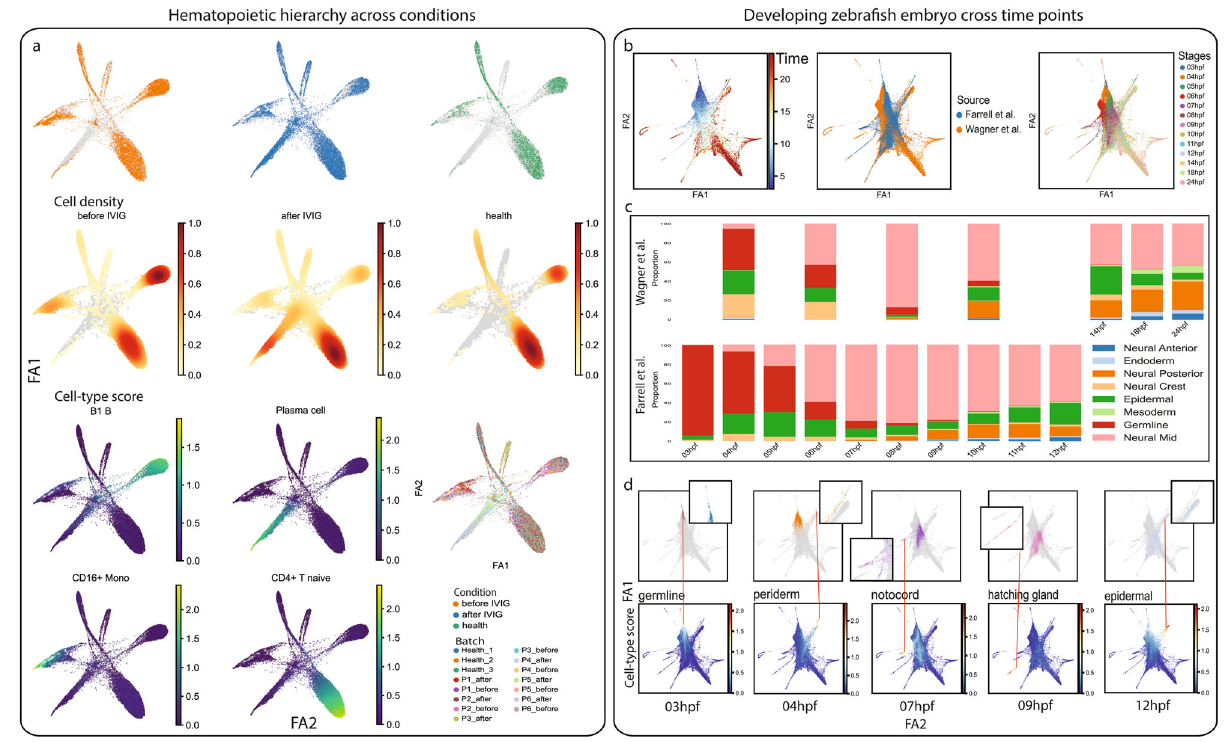
Fig. 1 Integrative lineage analysis using cell-type score matrix. a Integrative lineage analysis for multi-condition human hematopoiesis study 43 . Cell density, cell-type score, and batch id for human hematopoiesis samples under different conditions are visualized separately through the fi rst two ForceAtlas2. b integrative lineage analysis for two developing zebra fi sh embryo data 45,46 . Cells are visualized through UMAP and are colored according to developmental time (left), study id (middle), and developmental stages (right). c Compositions of eight major lineages along the developmental stages in zebra fi sh embryo. All lineages sum up to 1 in one stage, and data from the two studies are visualized separately. d Identi fi cation of lineage origin time. Visual investigation is conducted by matching emergence of a cell-type with the earliest developmental stage in the